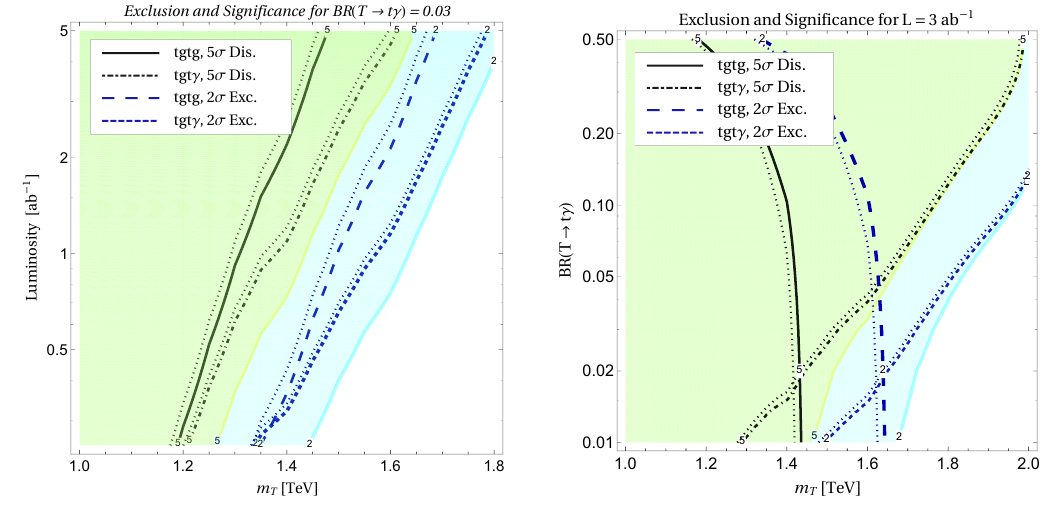
Figure 10 . The same as (cid:12)gure 9 but for spin- 3